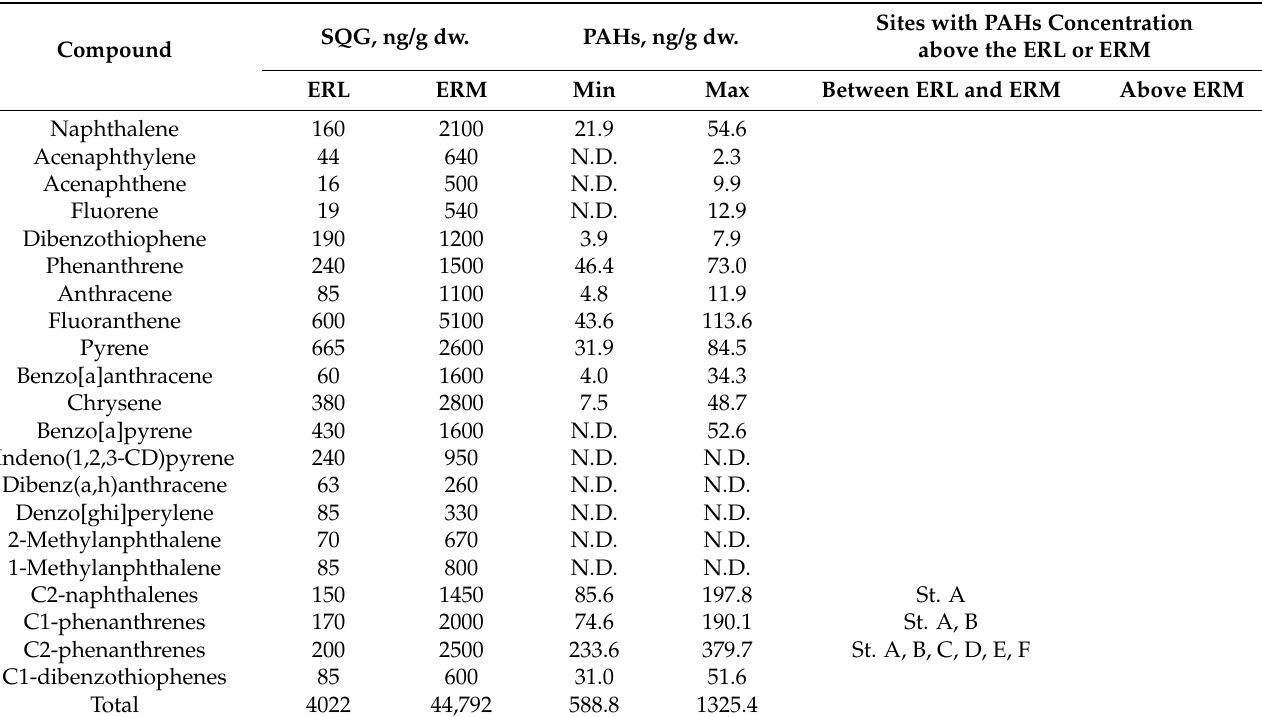
Table 9. A comparison of ERM and ERL values with PAH concentrations in sediment samples from Gwangyang Bay and the Yeosu